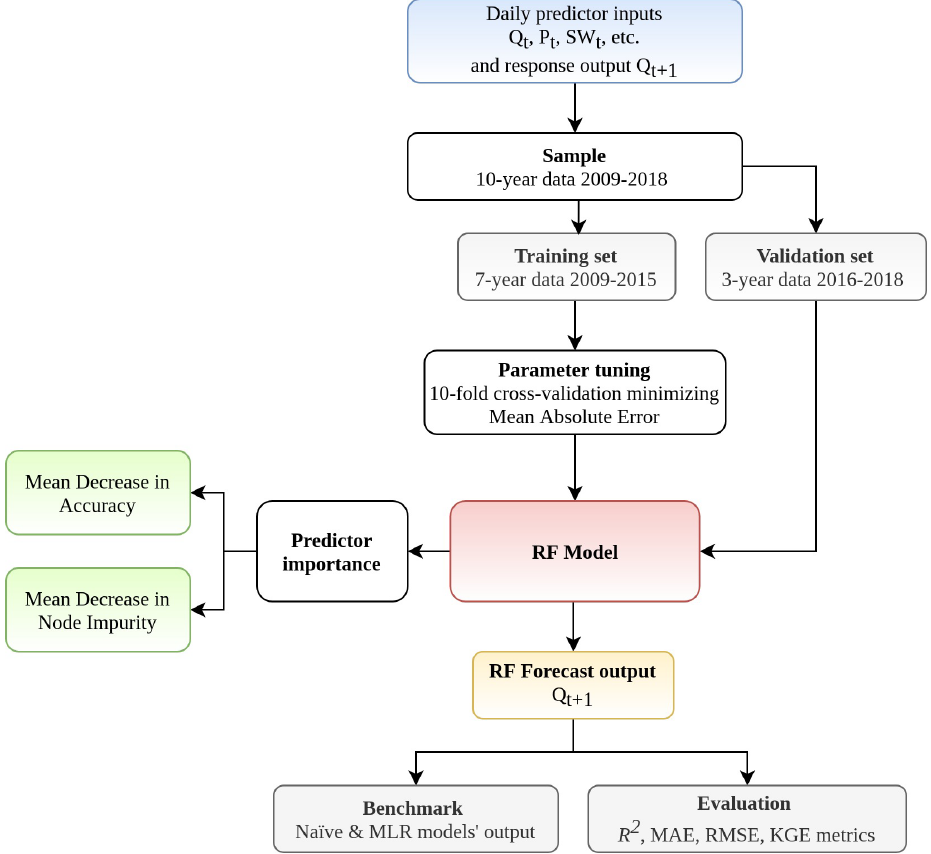
Figure 4. Flowchart showing the input–output model using RF.